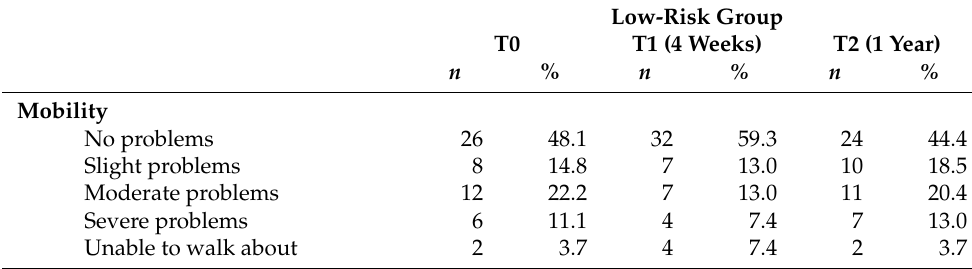
Table 3. Results of EQ-5D for low-risk